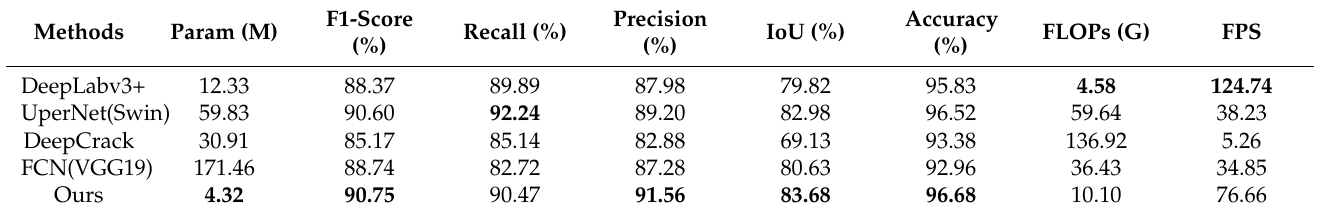
Table 5. Comparison with state-of-the-art deep learning models on our tunnel leakage